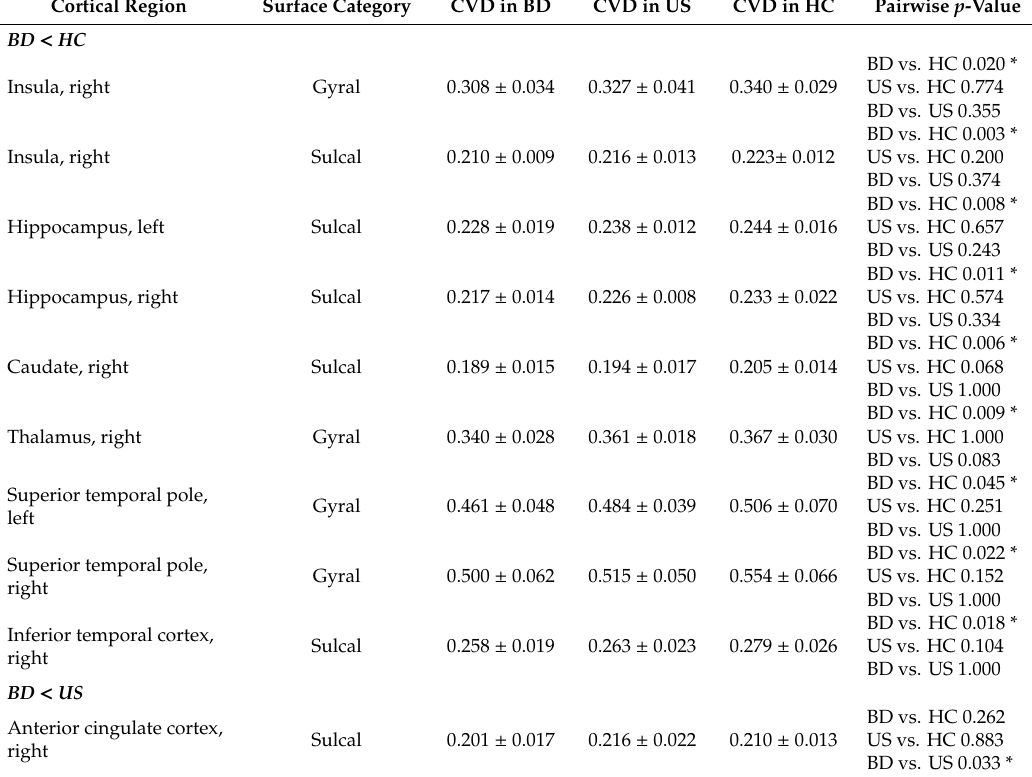
Table 3. Significant di ff erences in CVD values of BD patients, compared with healthy controls and una ff ected siblings.